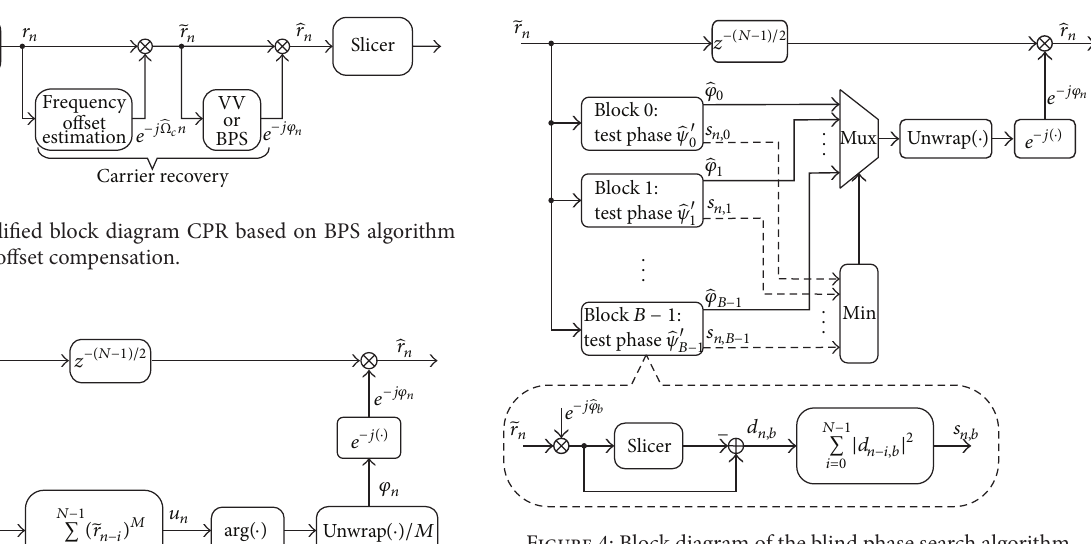
Figure 4: Block diagram of the blind phase search